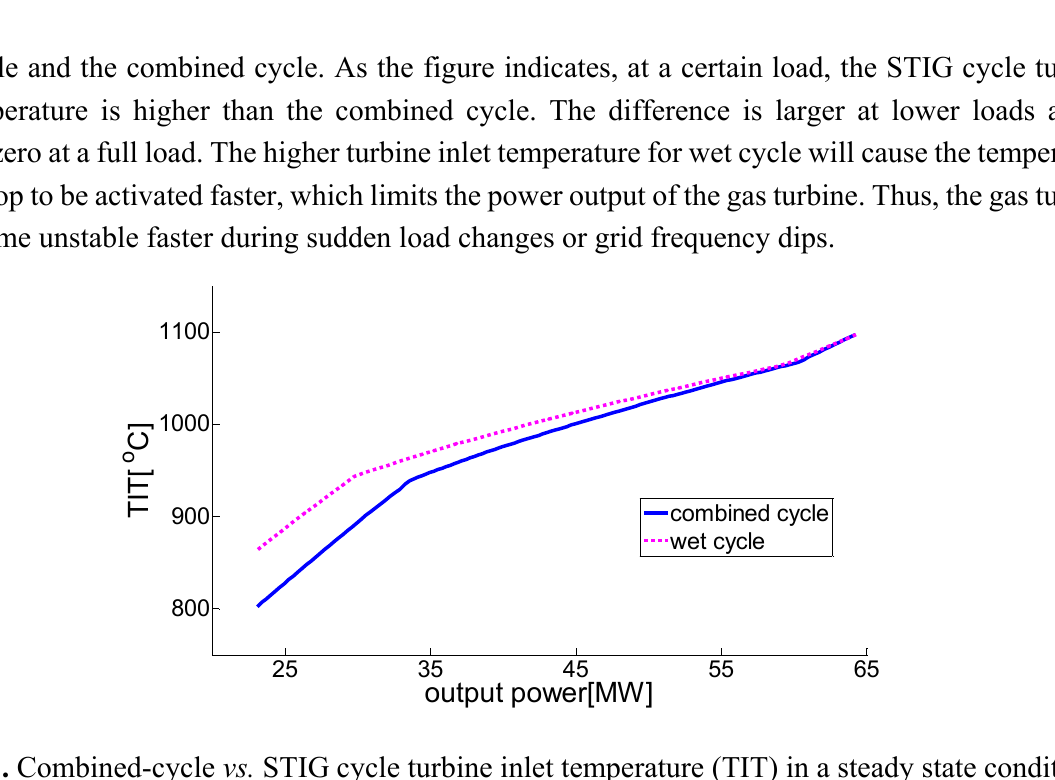
Figure 3. Combined-cycle vs. STIG cycle turbine inlet temperature (TIT) in a steady state